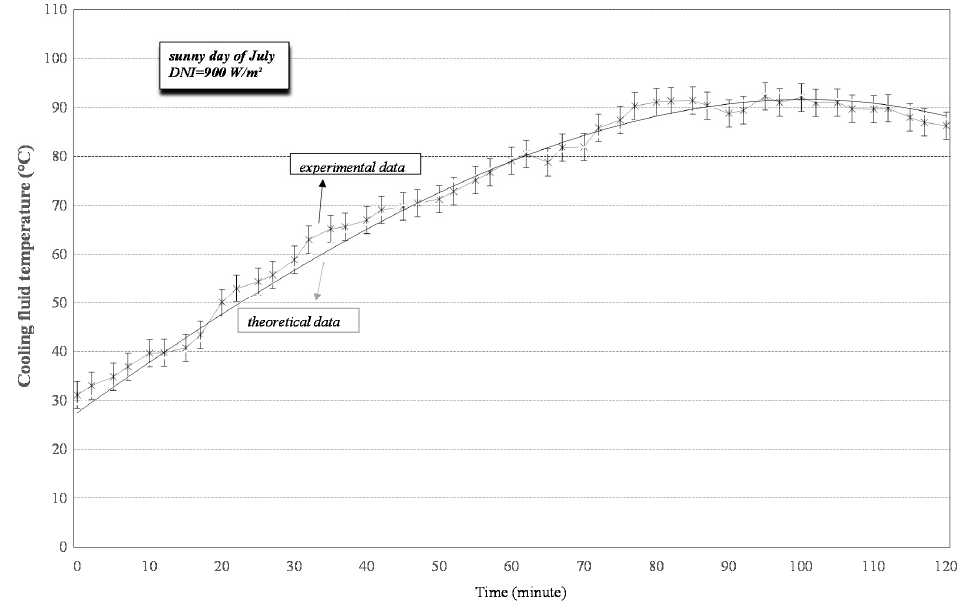
Figure 7. Experimental and theoretical comparison in terms of the cooling fluid outlet temperature of the CPV/T system in a sunny day.